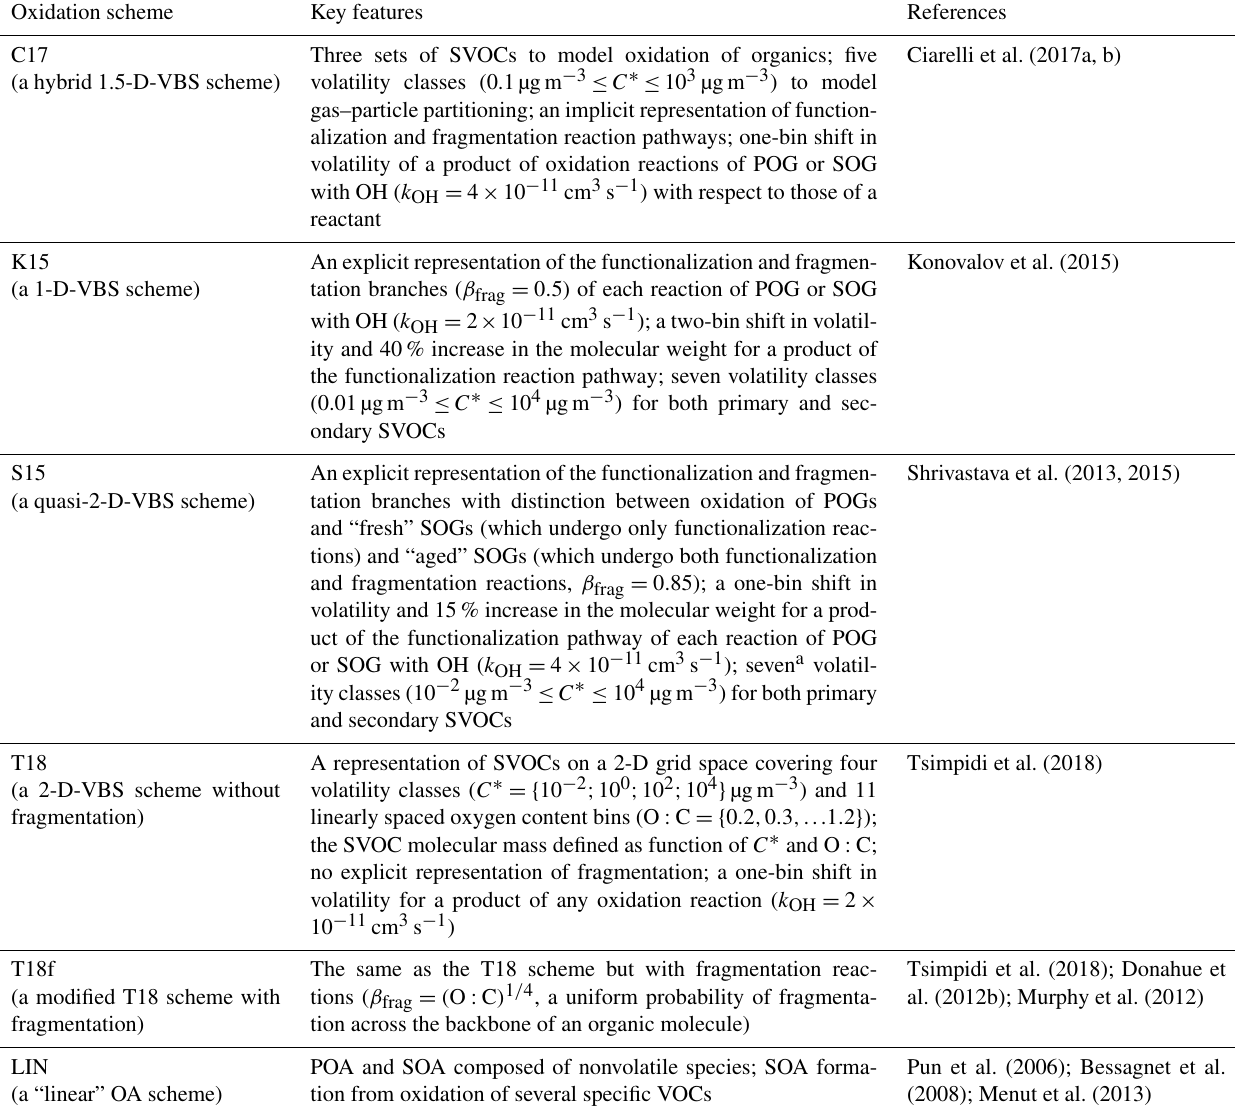
Table 1. Reference codes and main features of the BB OA modeling schemes used in the simulations. SVOC: semi-volatile organic com- pound. VOC: volatile organic compound. POG: primary organic gas. SOG: secondary organic gas. POA: primary organic aerosol. SOA: secondary organic aerosol. C ∗ : saturation mass concentration. β frag : fragmentation branching